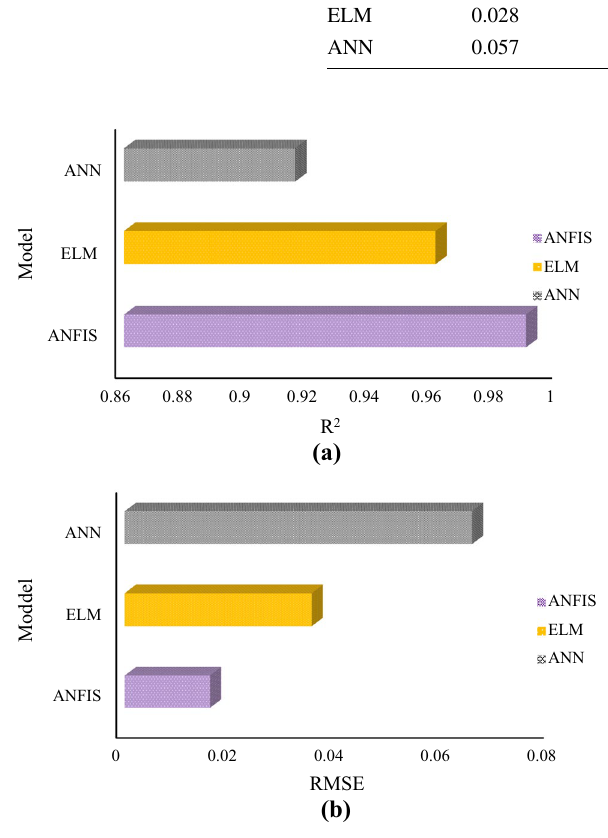
Fig. 6 a , b Comparison of ANFIS, ELM, and ANN models in esti- mating crop WP and WPe